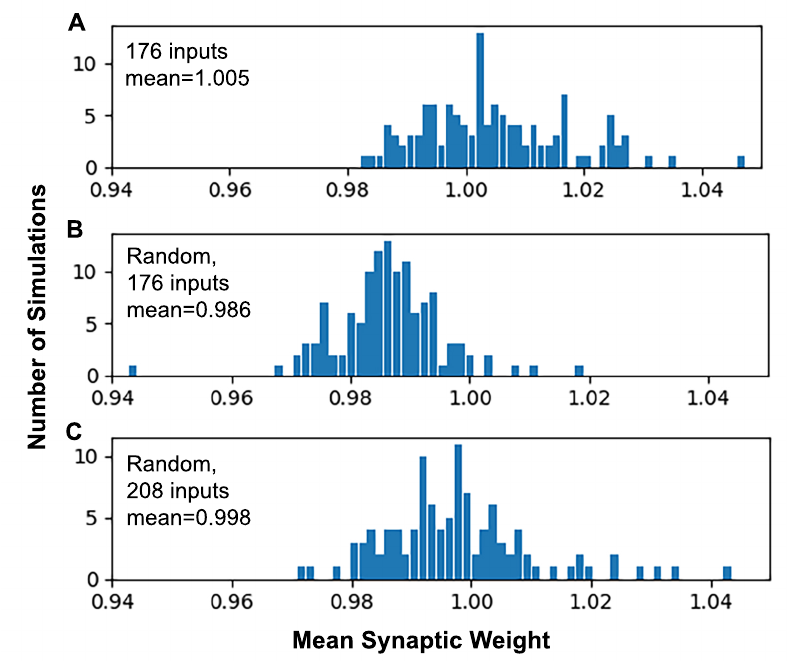
Figure A4. Simulations using shuffled ISIs. For each simulation, the synaptic weight at the end of 1 trial is averaged across all synapses. The distribution across the set of simulations is shown for three cases. ( A ) 176 synaptic inputs, where between neuron correlations are preserved. ( B ) 176 synaptic inputs with shuffled ISIs. Note that in most cases the mean synaptic weight is below 1.0. ( C ) 208 synaptic inputs with shuffled ISIs.